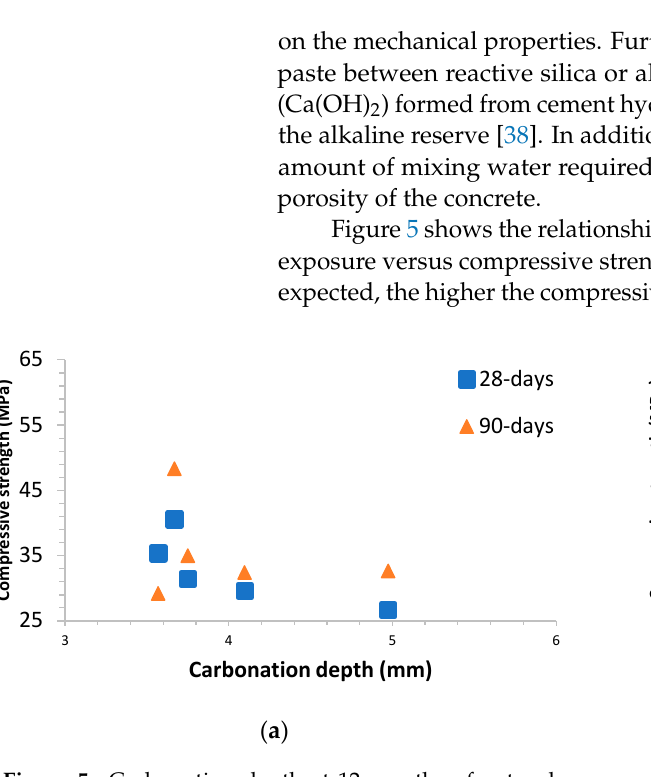
concrete A; ( b ) concrete B. ( a )